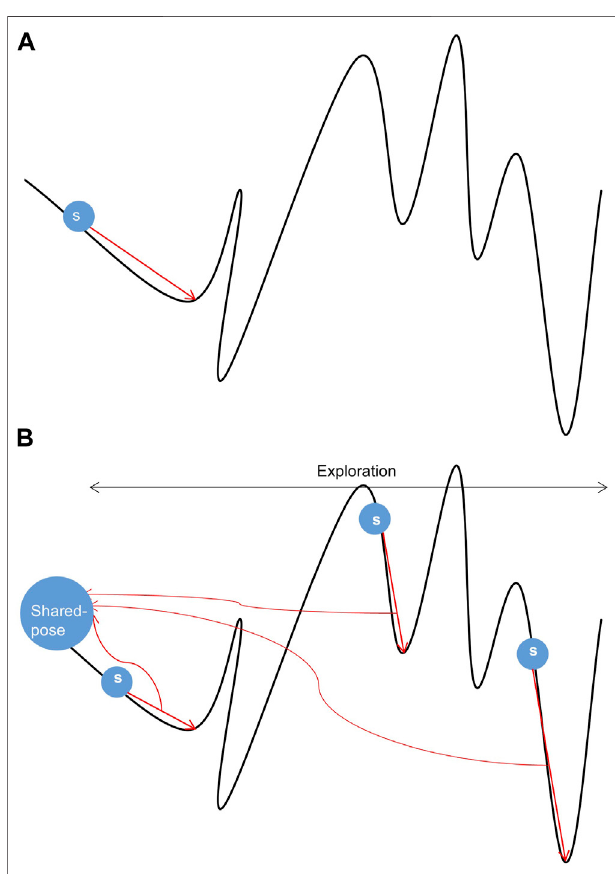
FIGURE 1 | Samples of conformational space. (A) Sampling under single-thread. (B) Sampling under multi-thread.